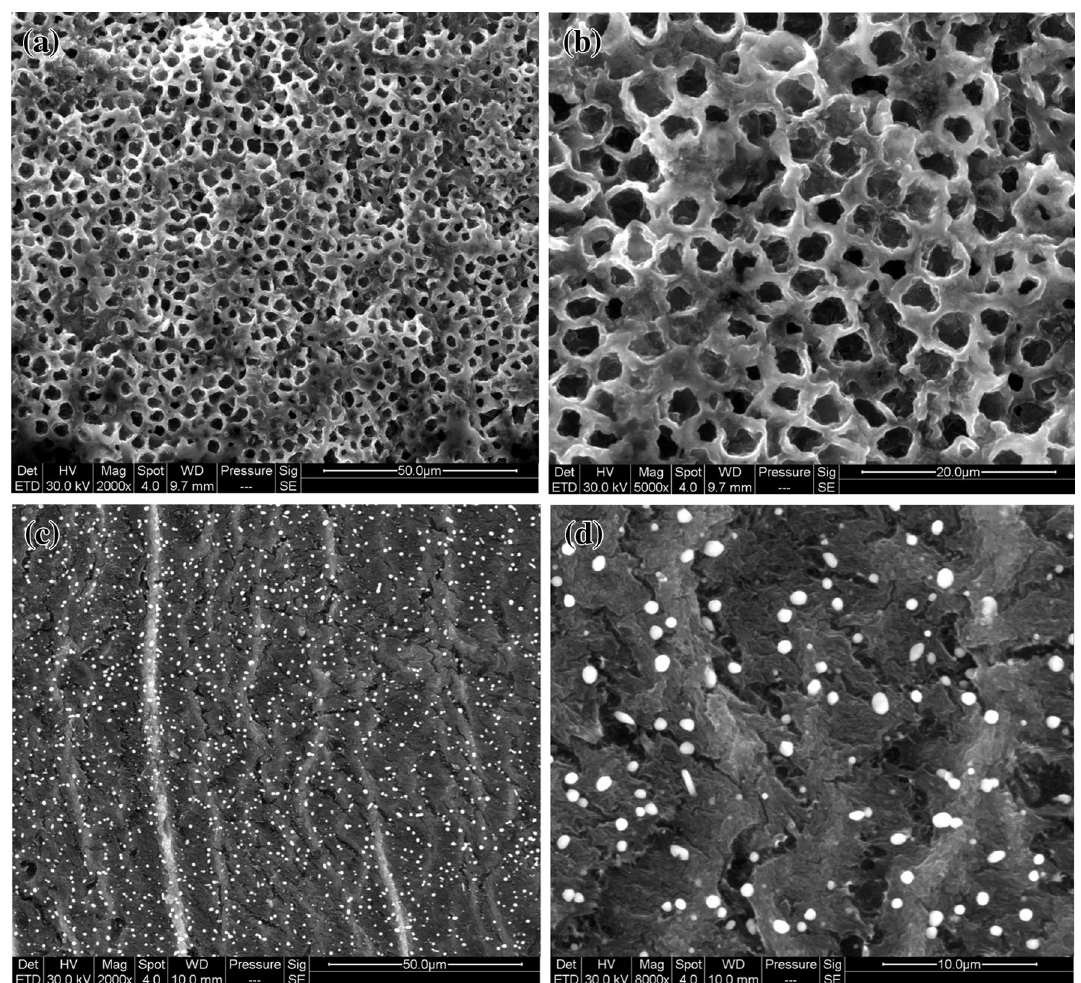
Figure 2. ( a ) SEM of outer surface is magnified 2000 times of ZVC/CTS-ACB. ( b ) SEM of outer surface is magnified 5000 times of ZVC/CTS-ACB. ( c ) SEM of inner cut surface is magnified 2000 times of ZVC/CTS- ACB. ( d ) SEM of inner cut surface is magnified 8000 times of ZVC/CTS-ACB.